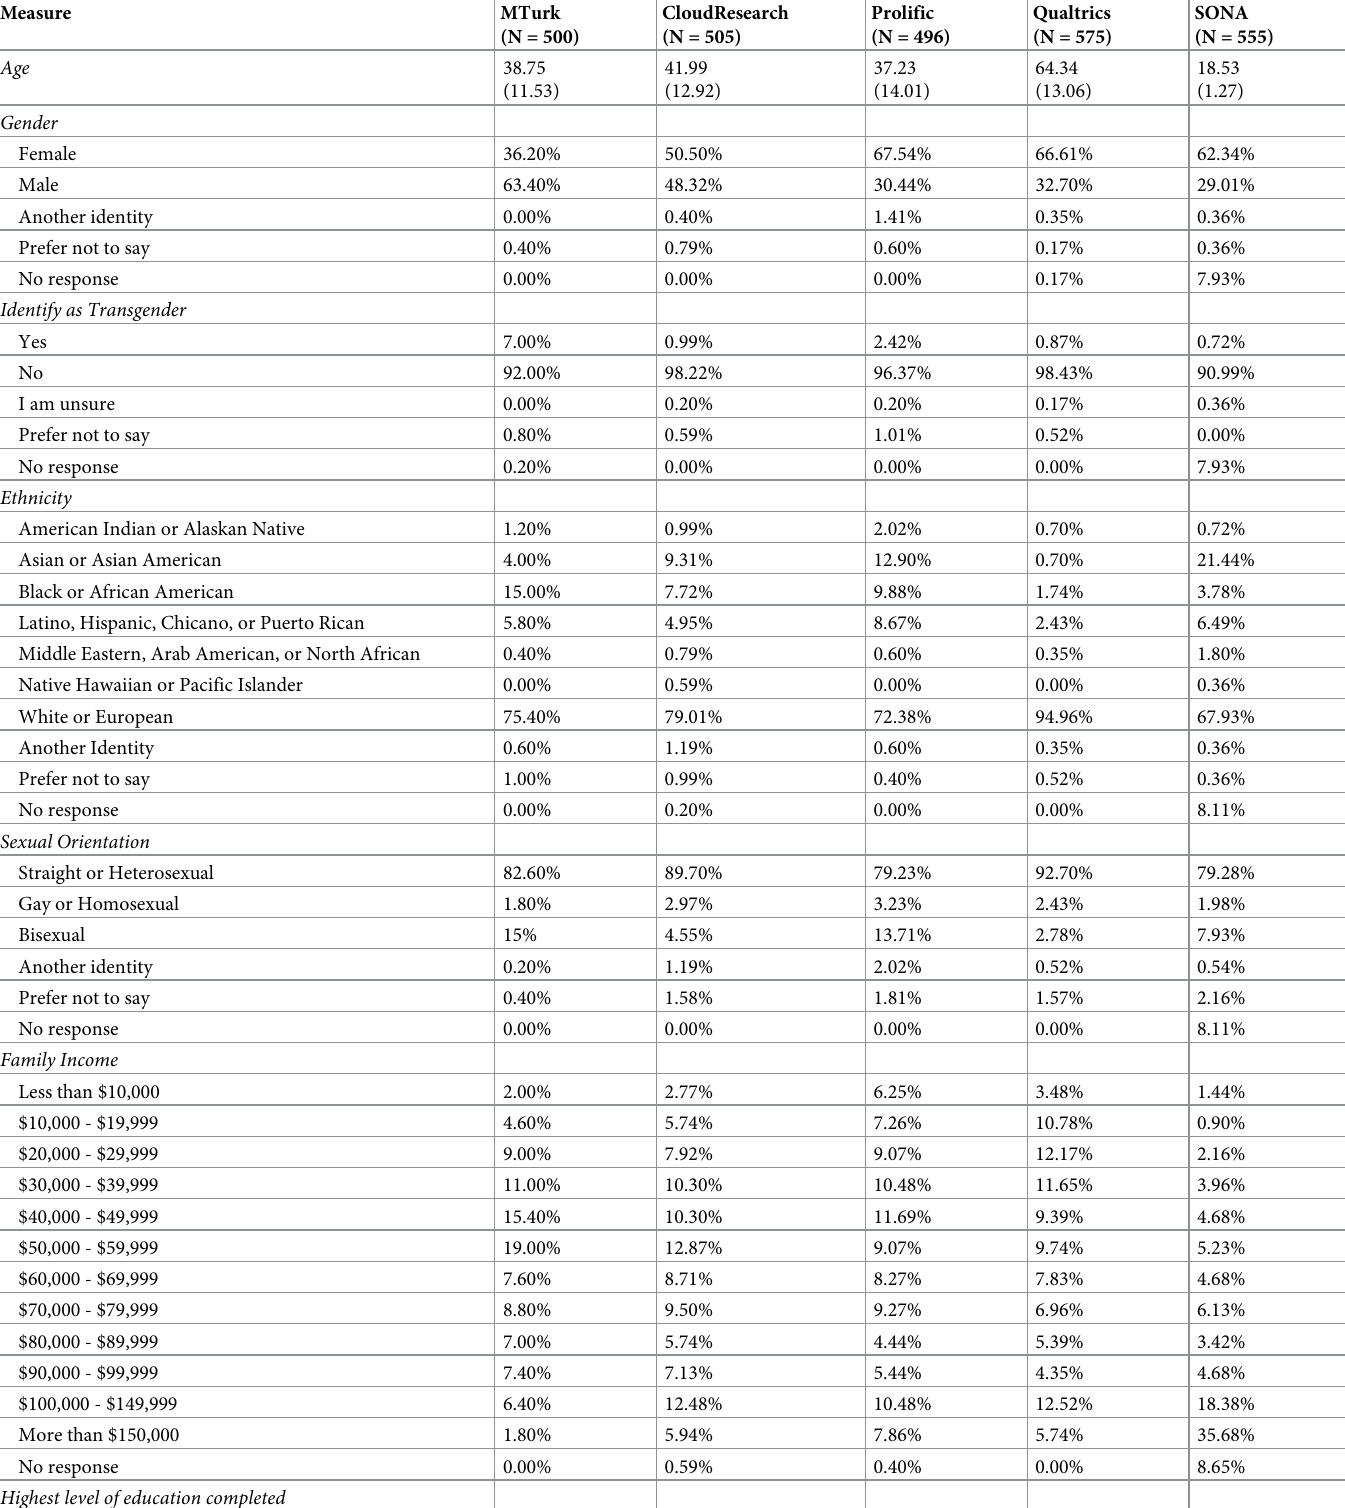
Table 1. Demographic information by